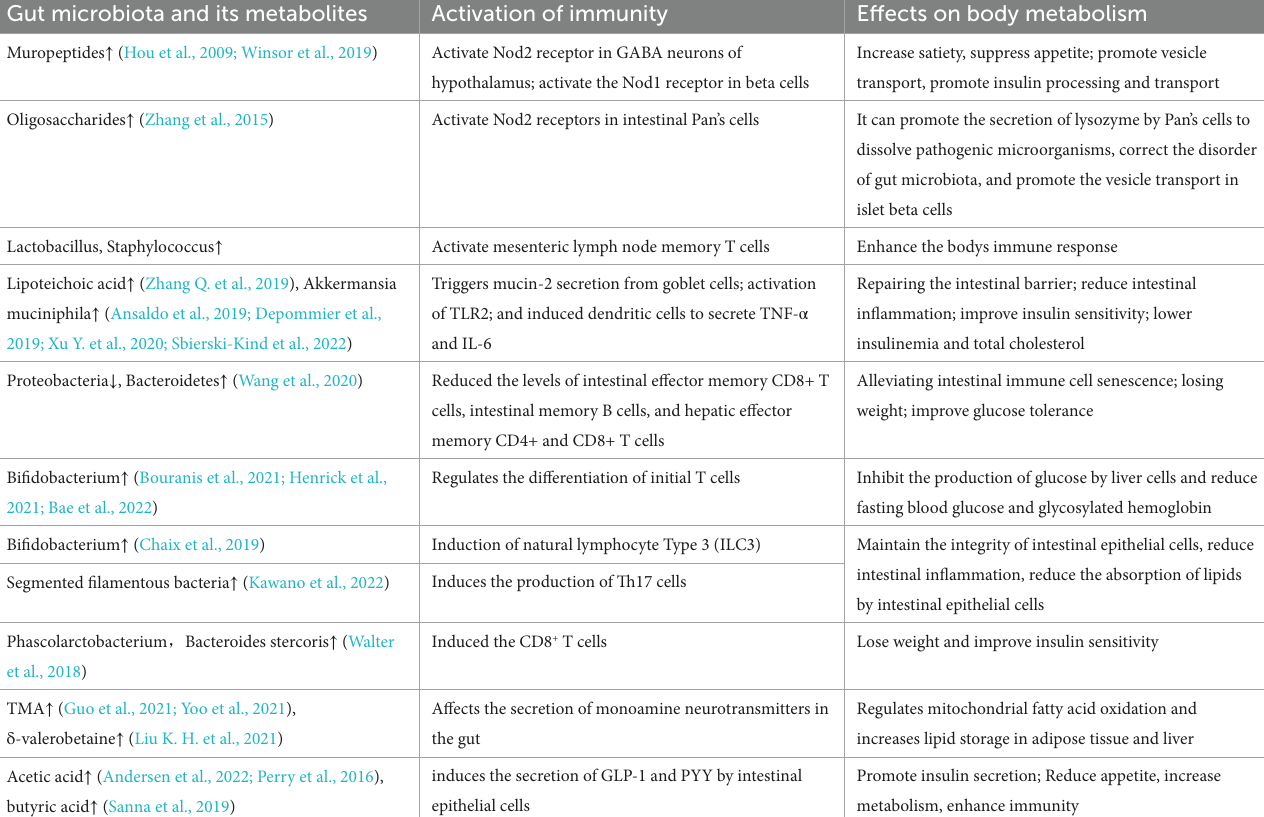
TABLE 1 Effects of gut microbiota and immune interaction on body